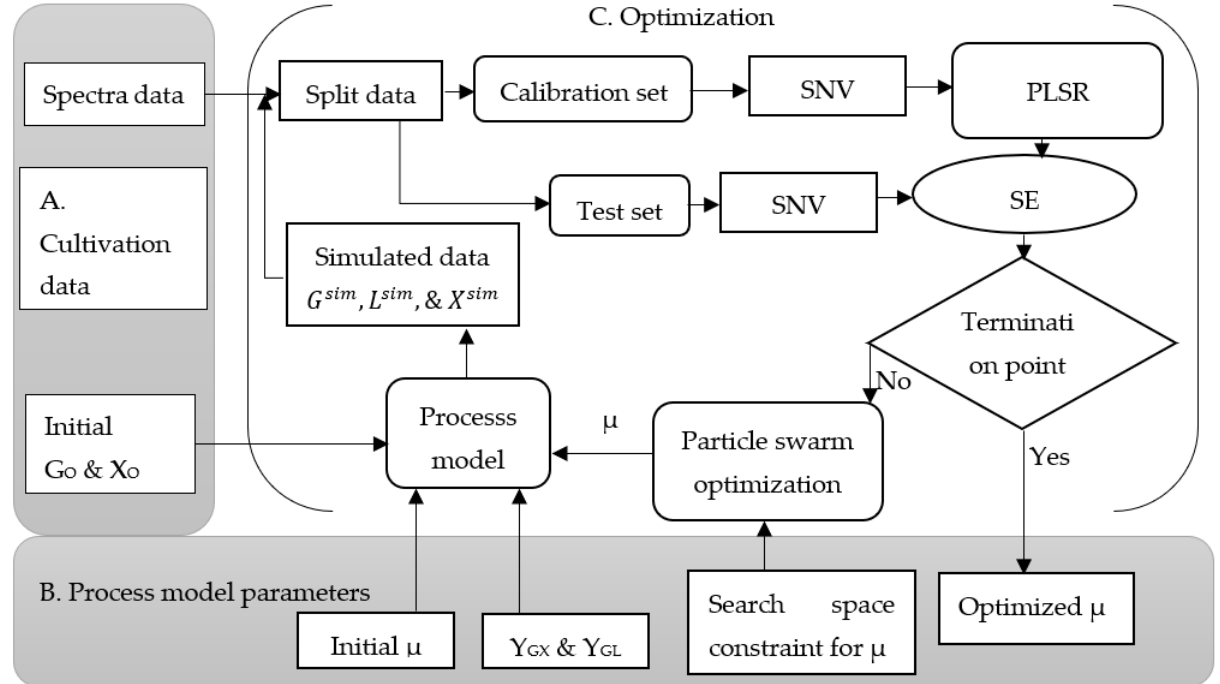
Figure 2. Model-based calibration process to fi nd the optimized parameters in the cultivation of Lactiplantibacillus plantarum A6 and Lacticaseibacillus rhamnosus GG; G O and X O are the initial concentrations of glucose and biomass, respectively; G off , L off , and X off are the offline data for glucose, lactic acid, and biomass, respectively; G sim , L sim , and X sim are the simulated data for glucose, lactic acid, and biomass, respectively; µ , microbial specific growth rate; Y GX , yield coefficient with respect to the conversion from glucose to biomass; Y GL , yield coefficient with respect to the conversion from glucose to lactic acid; SNV is the standard normal variate; SE is the sum of the error; and PLSR is the partial least square regression. ( A ) shows spectra data and initial values of biomass and glucose; section ( B ) serves as input for the main optimization cycle carried out in section ( C ) with the initial parameters for the theoretical process model and the corresponding search space costraints.